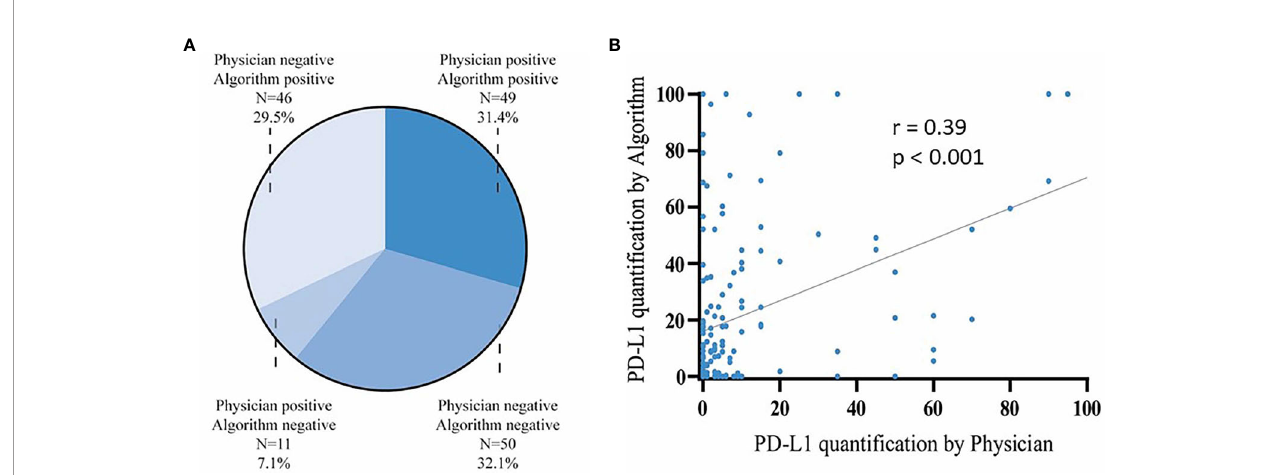
FIGURE 3 | Comparison of PD-L1 calculation by physician and digital algorithm. (A) Distribution of PD-L1 quanti fi cation in tumor tissue specimen of n=156 melanoma patients by the physician and the digital algorithm. (B) Correlation of PD-L1 quanti fi cation by the physician (x axis) versus the digital algorithm (y axis) in n=156 patients (Pearson ’ s correlation; r = 0.39; p < 0.001).